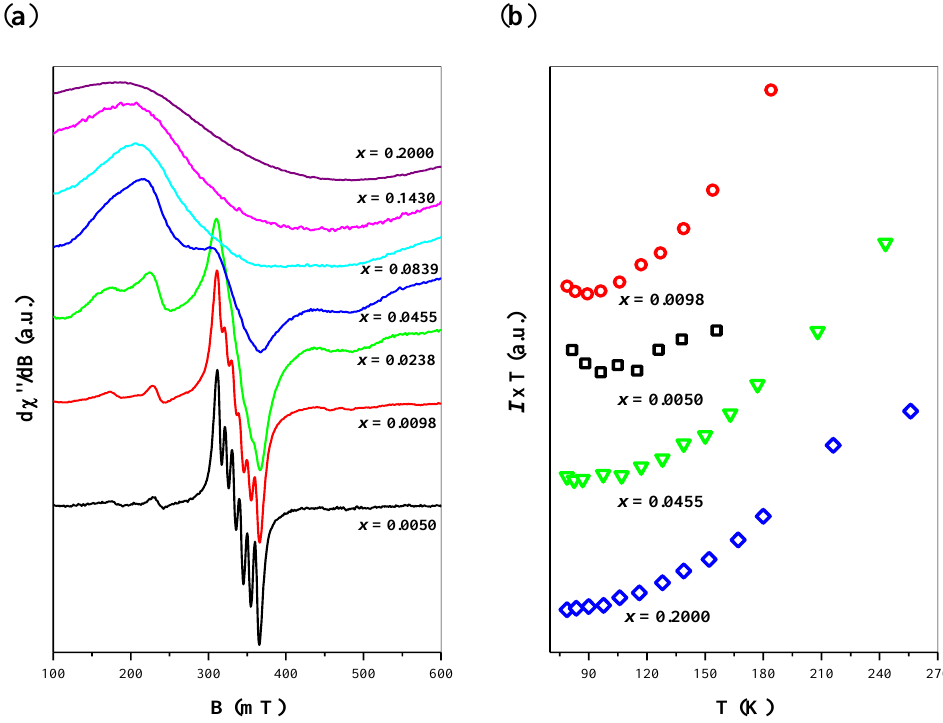
Figure 10. EPR spectra of CaMnGdMoWO samples with varied Gd 3+ doping obtained by solid state reaction method ( a ); Temperature variation of I . T product, where I - integral intensity of EPR signal ( b ).